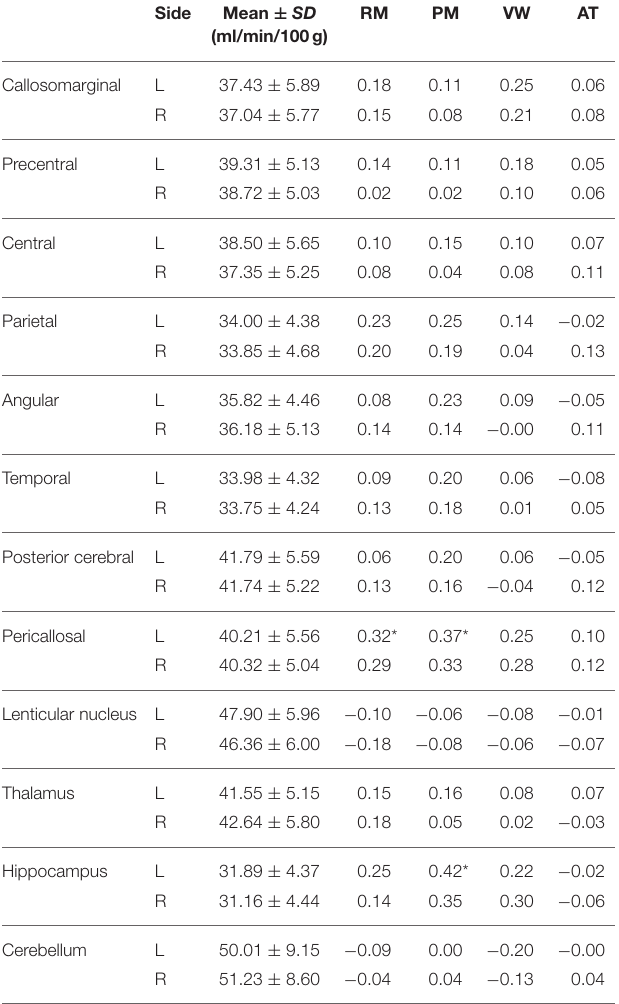
TABLE 4 | Correlation analyses between the factor scores and rCBF. Side AT